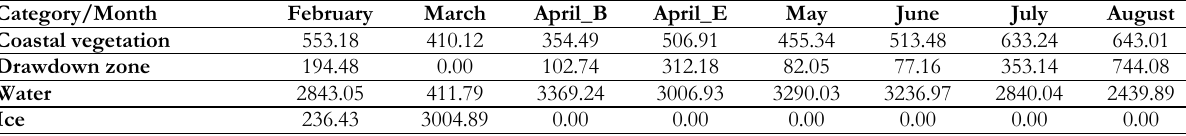
Figure 7. An image of the area of interest from May 2018 Table 1. Changes in the monitored categories in individual time